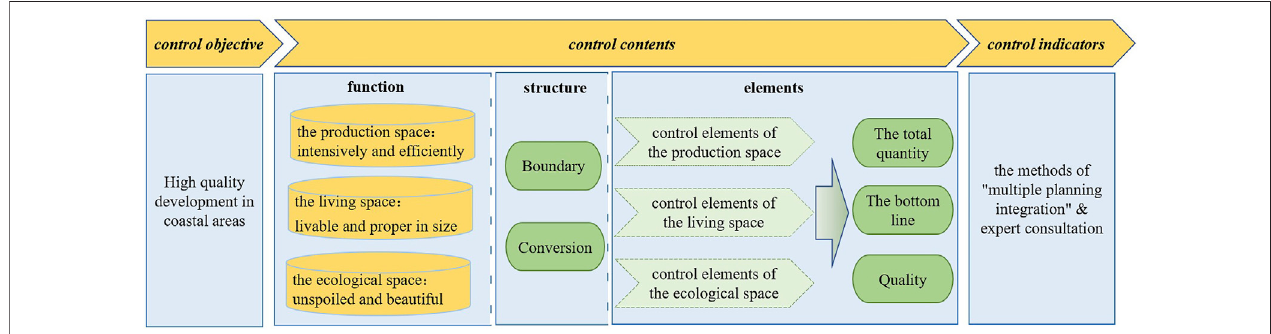
FIGURE 3 | Construction idea of the coastal zone spatial control index